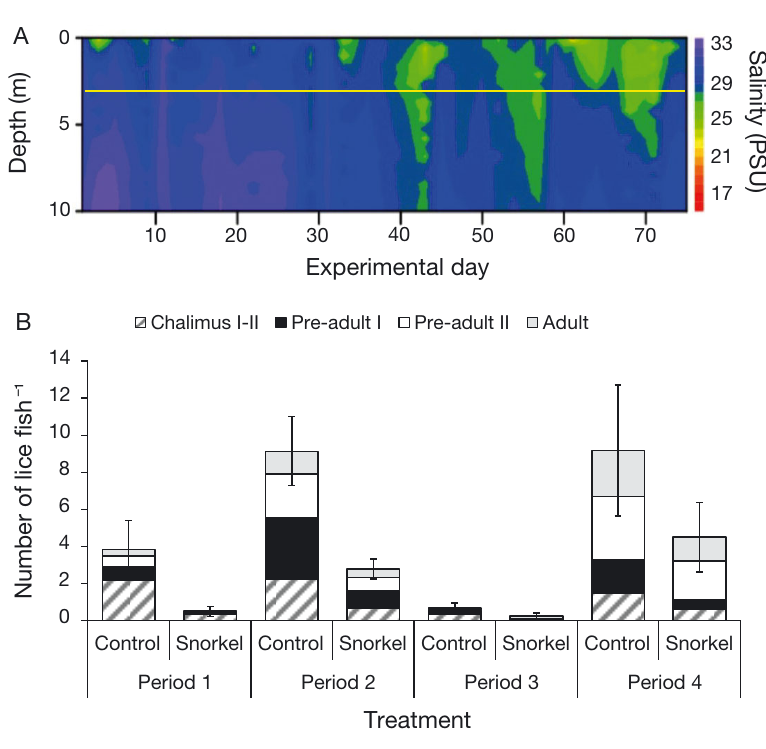
Fig. 1. (A) Continuously recorded vertical salinity profile of the water col- umn from 0−10 m depth for Expt 1 conducted at a coastal site with an un- systematic halocline (Austevoll) over the 76 d experimental period. Solid yellow line: maximum depth (3 m) of the anti-lice barrier. (B) Mean (±SE) abundances of different developmental stages of salmon lice fish −1 for each period in Expt 1. Bars represent the mean of 20 Atlantic salmon in each of 3 lice-barrier or control